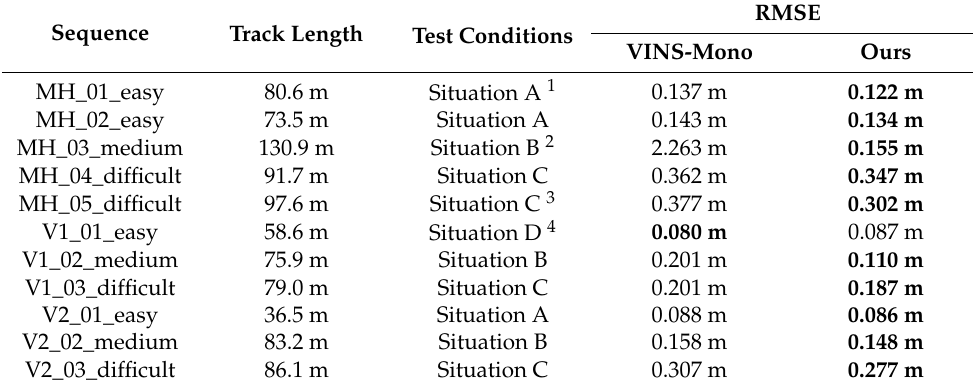
Table 2. APE root mean square error(RMSE) in EuRoc datasets.